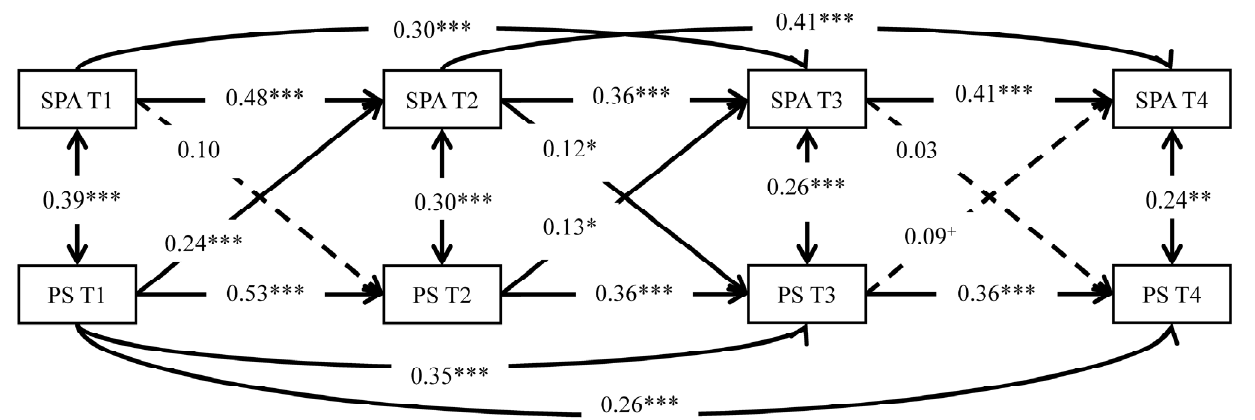
Figure 1. The cross-lagged model among smartphone addiction (SPA) and perceived stress (PS)